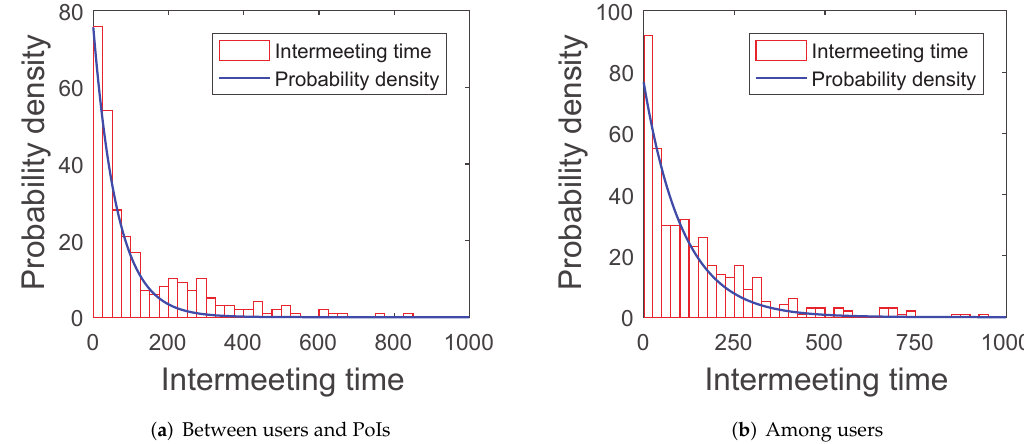
Figure 5. Random-waypoint mobility